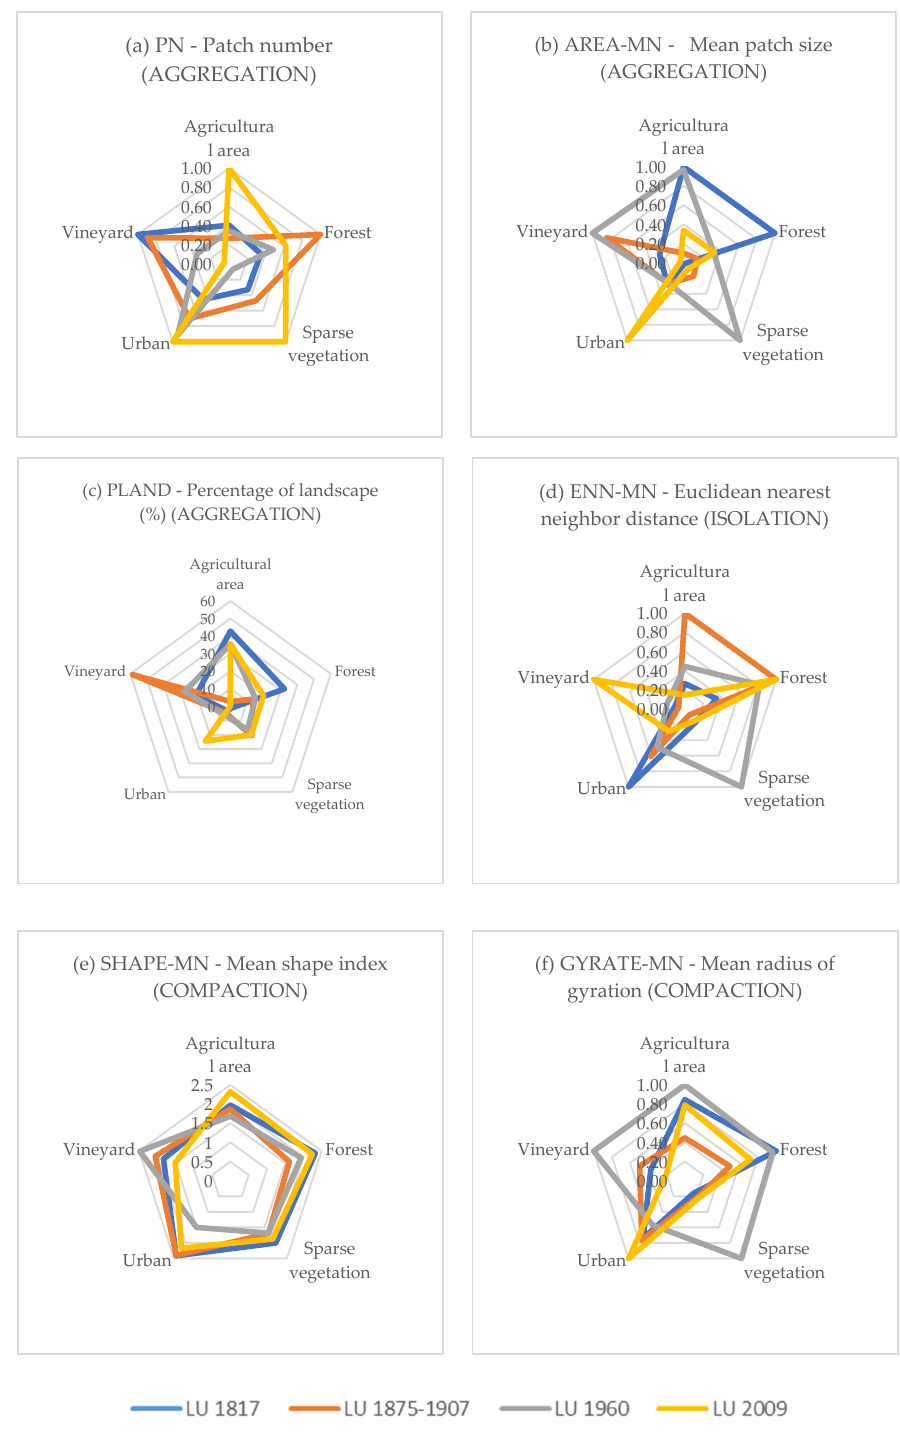
Figure 9. Landscape metrics results in normalized values: ( a ) PN—Patch number; ( b ) AREA-MN—Mean patch size; ( c ) PLAND—Percentage of landscape; ( d ) ENN-MN—Euclidean nearest neighbor distance; ( e ) SHAPE-MN—Mean shape index; ( f ) GYRATE-MN—Mean radius of gyration.